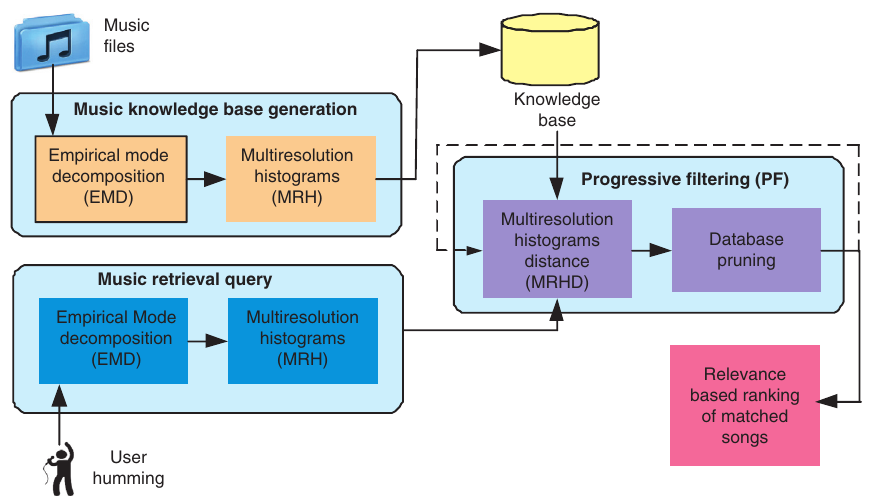
Figure 1. Proposed QBH